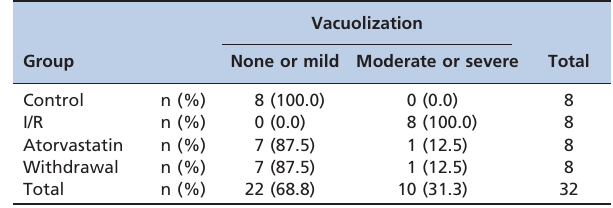
Table 5 - The combined results of the vacuolization of the spinal cord samples for each